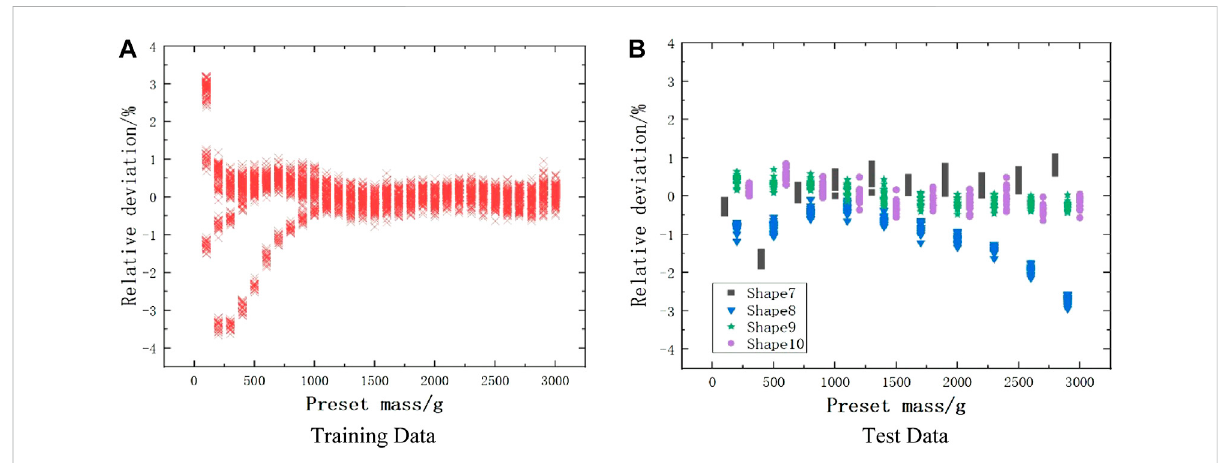
FIGURE 8 Multi-layer perceptron predicts quality deviations. (A) Training Data. (B) Test Data.